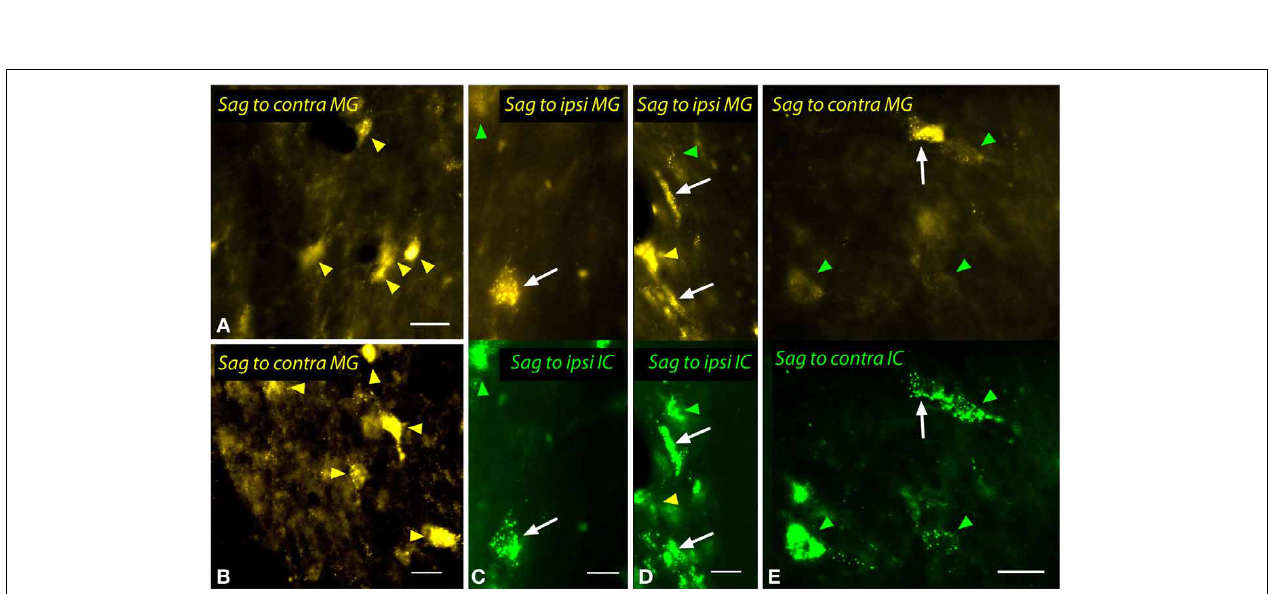
middle panel shows green bead label and the bottom panel shows an overlay of the two images. Most cells were labeled with only FluoroGold (yellow arrowheads) or only green beads (green arrowheads). (F) Double-labeled cell (white arrow) in the left paralemniscal area after injections of FluoroGold into the left MG and green beads into the left IC (GP597). The upper half shows the cell labeled with FluoroGold and the lower half shows the same cell imaged to show green beads. Scale bar = 20 µ m and applies to all panels. Transverse sections; dorsal is up; lateral is to the left except for panel (D) , where lateral is right. Abbreviations: contra, contralateral; ipsi, ipsilateral.